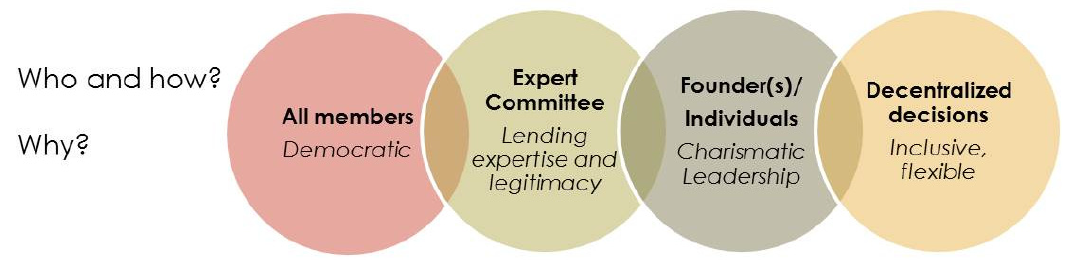
Figure 5. Consequential roles in decision-making.